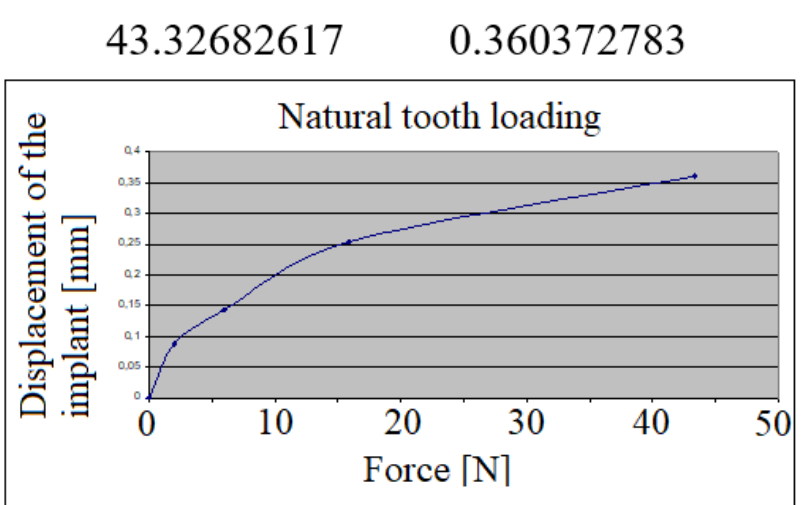
Figure 9. The implant’s displacement during the natural tooth’s loading. Monitoring the masticator act, in this case, the relative displacements of the unloaded dental implant and the loaded tooth offered the next values, presented in the diagram in Figure 10, where the curvilinear aspect can be observed.